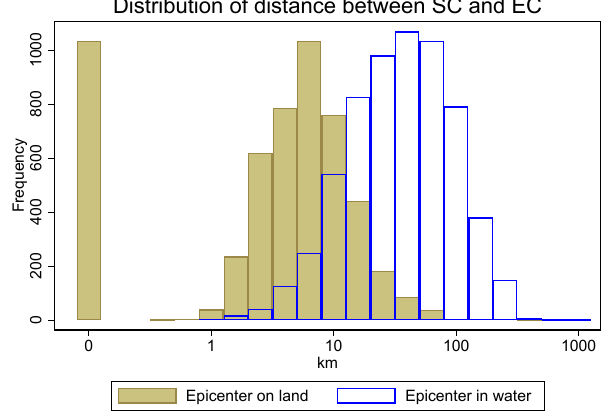
Figure 4. Comparing the epicenter (EC) and the shaking center (SC) in terms of distance for all 11510 earthquakes with shaking and magnitude 4.5 or greater. In only about 9% of earthquakes does the epicenter coincide with the shaking